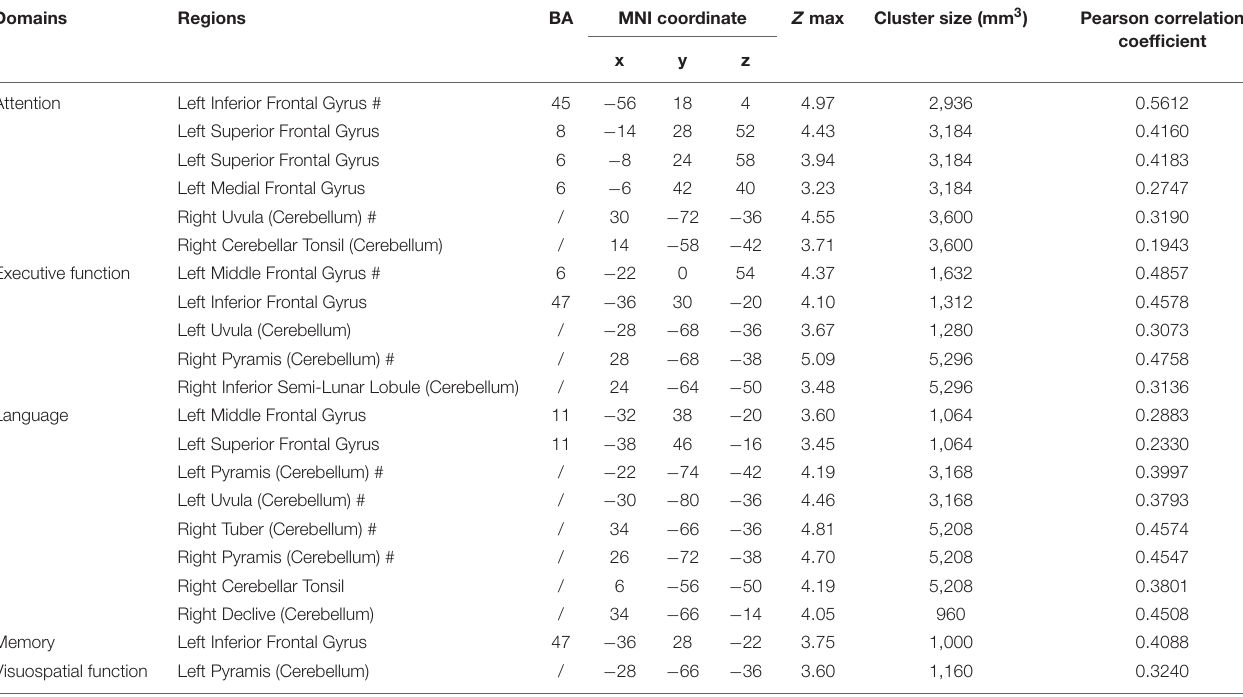
TABLE 2 | Brain regions in the 84 patients with MSA exhibiting positive correlations between the Z -score of cognitive domains and regional brain metabolism adjusting for education and Unified Parkinson’s Disease Rating Scale (UPDRS) score. Domains Regions